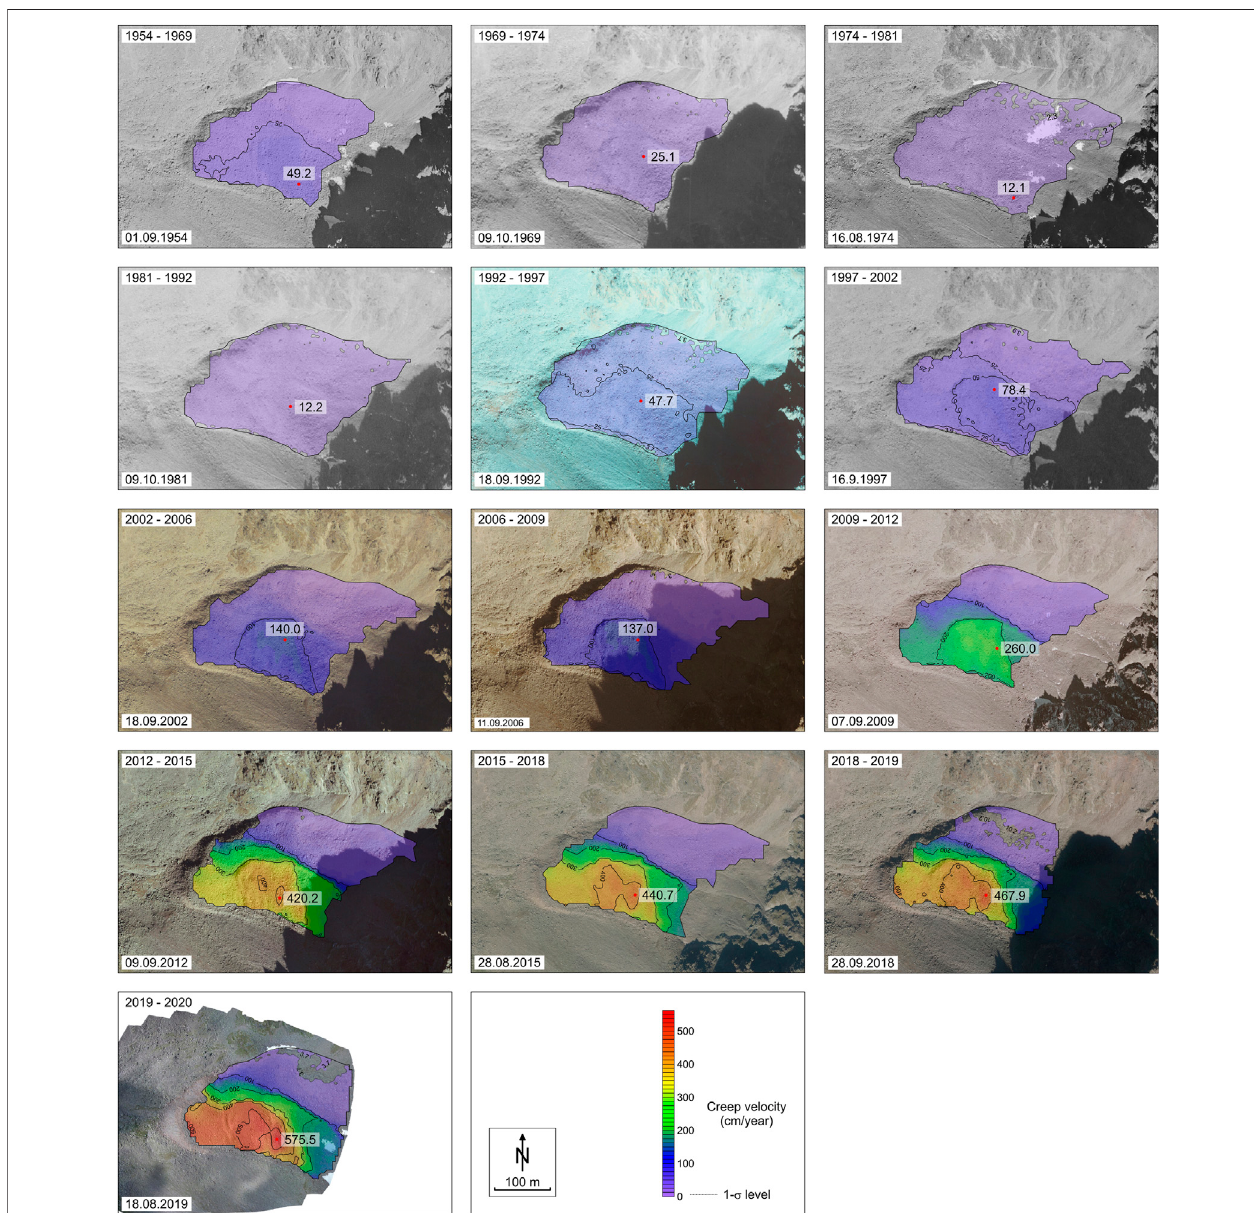
FIGURE 4 | Color-coded velocity maps 1954 – 2020. The position of the maximum surface creep velocity is indicated by a red dot. The acquisition date of the backdrop orthophoto is given in the lower left corner of each map.